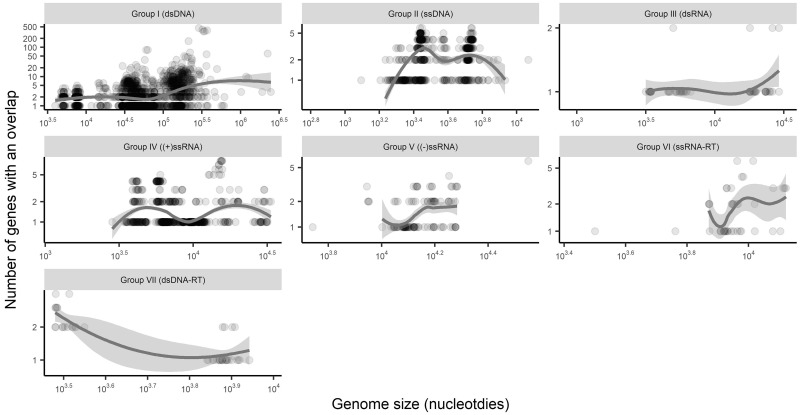
Number of genes involved in gene overlap by genome size (excluding all genomes with no overlap). Trend lines are Loess curves with span 0.80. Both the x and y axes depict log scales.